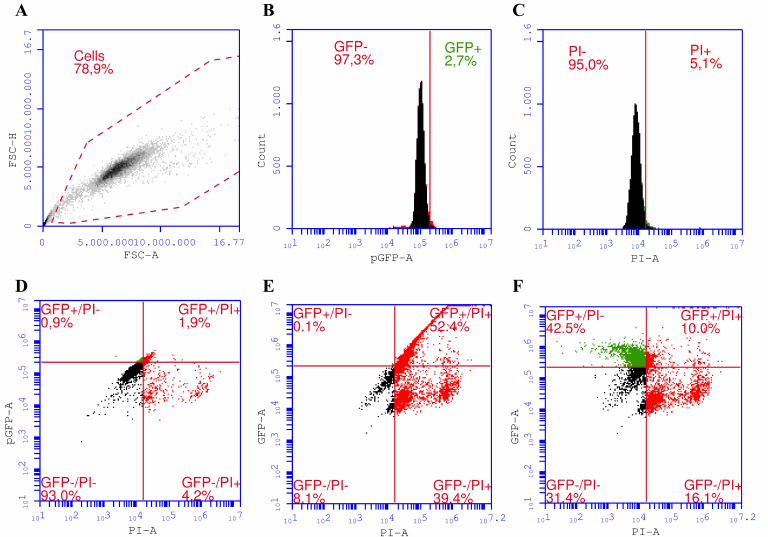
Figure 1. Schematic representation of gating of the samples to distinguish four subpopulations of UT-7 cells representing pEGFP transfected/viable (GFP+/PI − ), transfected dead (GFP+/PI+), untransfected/viable (GFP − /PI − ) and untransfected/dead (GFP − /PI+) cells. Gating strategy: cells in the control sample according to forward scattering–area (FSC-A) vs. forward scattering–height (FSC-H) ( A ), control sample in GFP channel after 6% compensation ( B ), a control sample in PI channel after 6% compensation ( C ), GFP vs. PI gating of the control sample ( D ), GFP vs. PI gating of the GET sample without compensation ( E ), GFP vs. PI gating of the GET sample after 6% compensation ( F